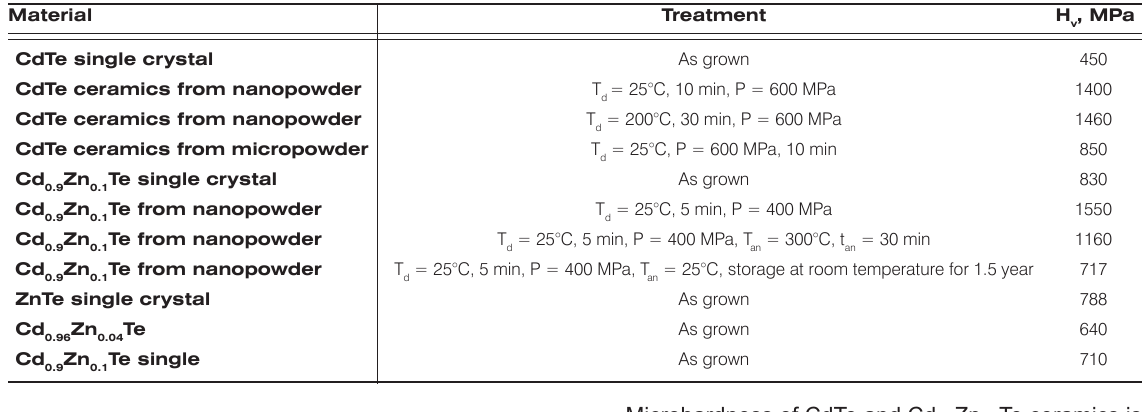
Table 1. Microhardness of ceramics and single crystals